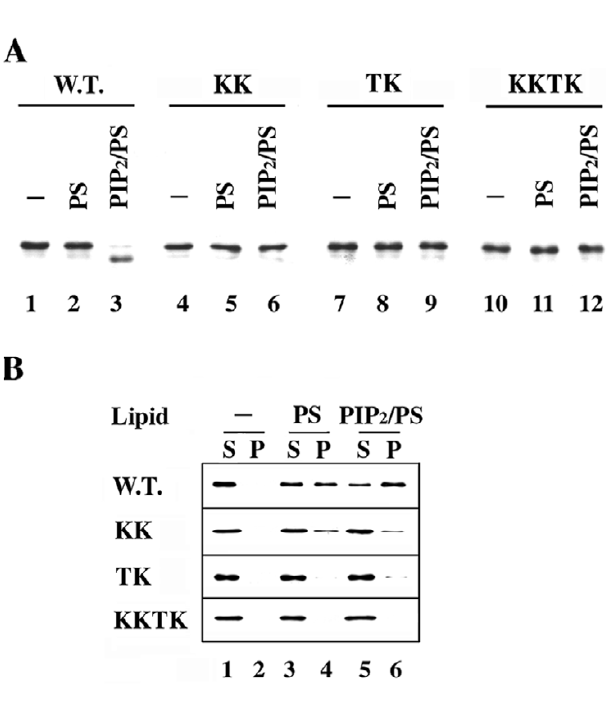
Figure 5 Effects of the KK, TK, and KKTK substitutions on the association of Boi-PH with phospholipids. A).